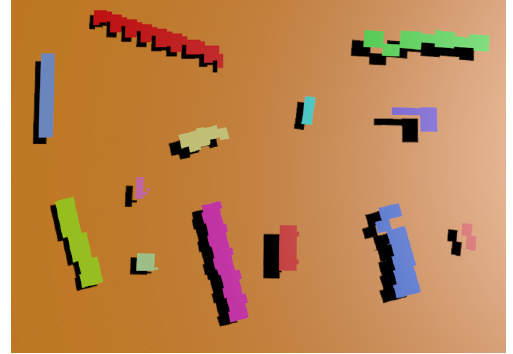
Figure 7: The grown regions, where every region is assigned a different colour.